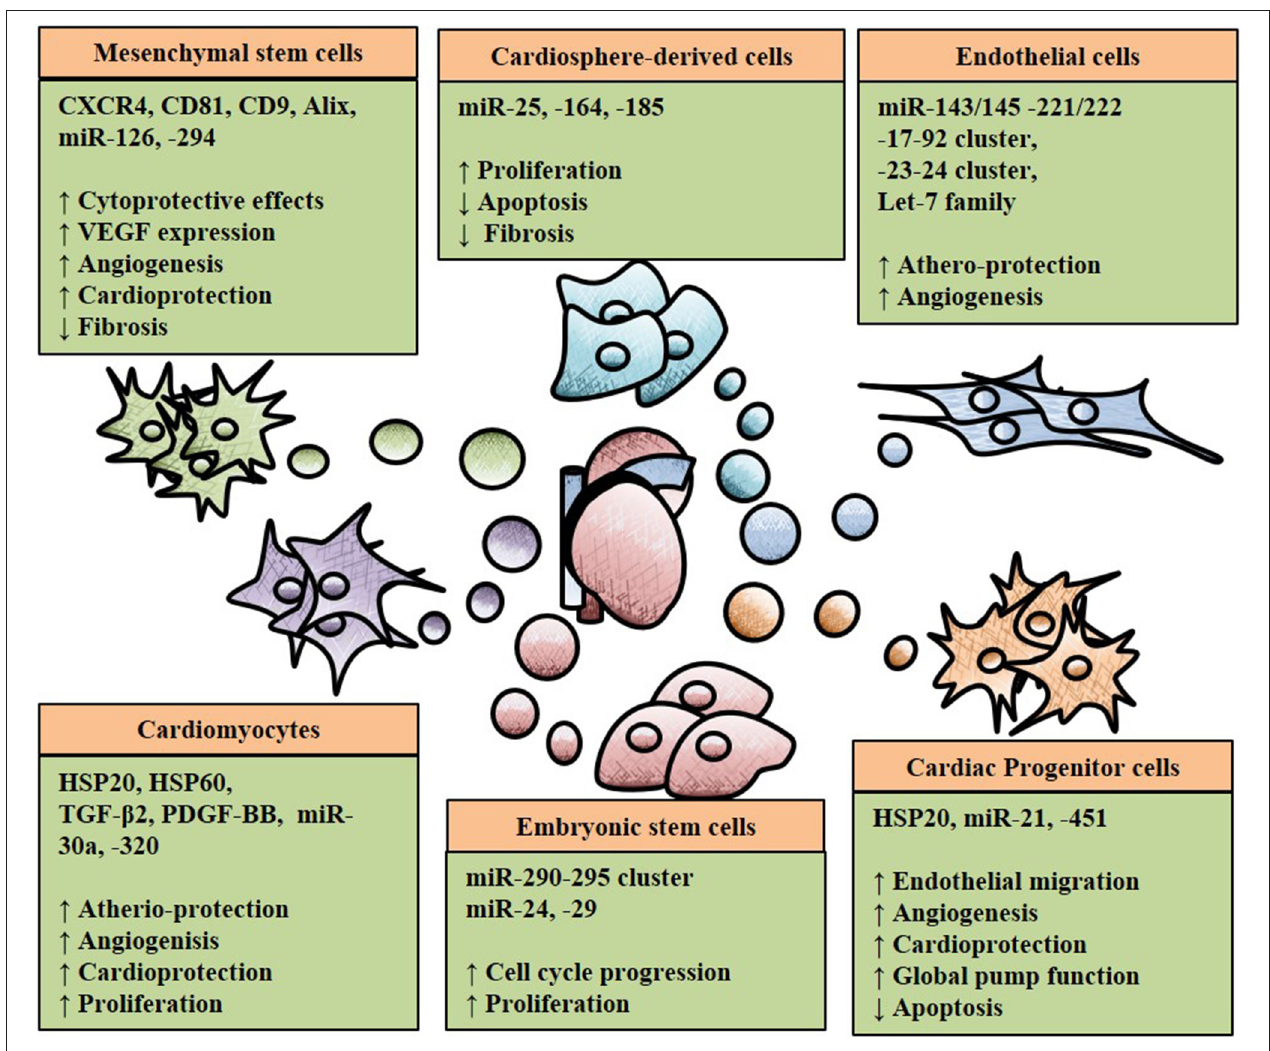
FIGURE 2 | An overview of six different cell types secreting exosomes with therapeutic potential in ischemic heart disease. Exosomes represented as spherical geometries containing heatshock proteins (HSP), microRNAs (miRs), growth factors such as transforming growth factor beta 2 (TGF- β 2). The impact of exosomes in inducing ( ↑ ) or decreasing ( ↓ ) is also indicated with the